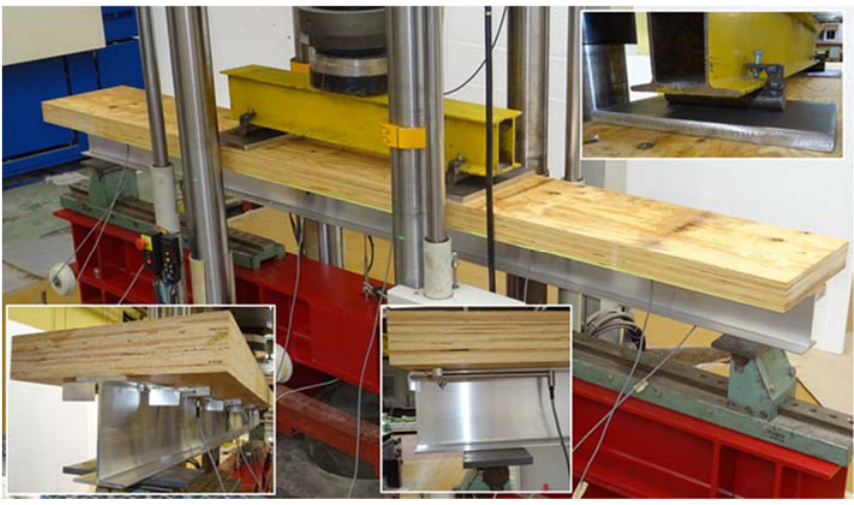
Figure 1. Four ‐ point bending test set ‐ up. Figure 1. Four-point bending test